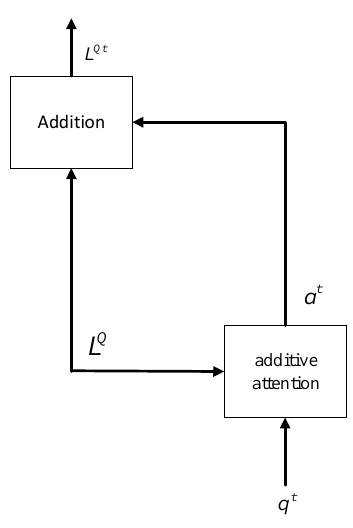
Figure 2. Temporal attention module.